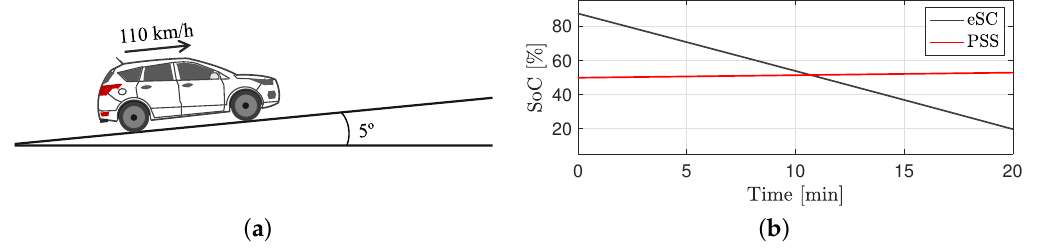
Figure 3. ( a ) Vehicle climbing a 5 ◦ hill at 110 km/h , ( b ) a 2.5 kWh battery state of charge (SoC) variation for the vehicle with PSS compared to the same vehicle with an electric supercharger